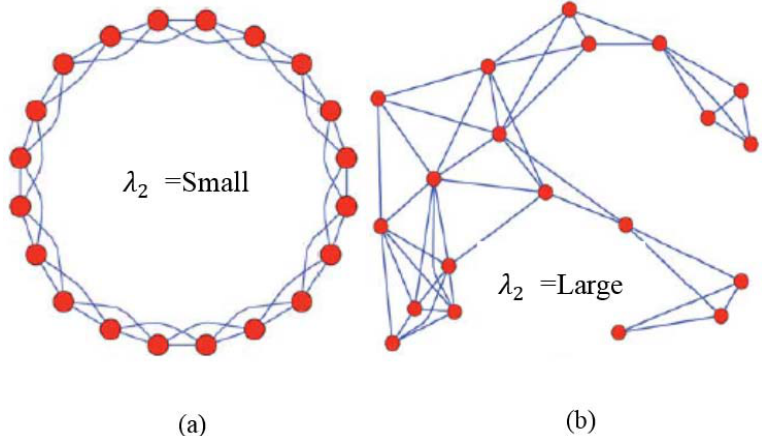
Figure 5. Examples of Networks [47]. ( a ) Regular Network ( b ) Random Network.